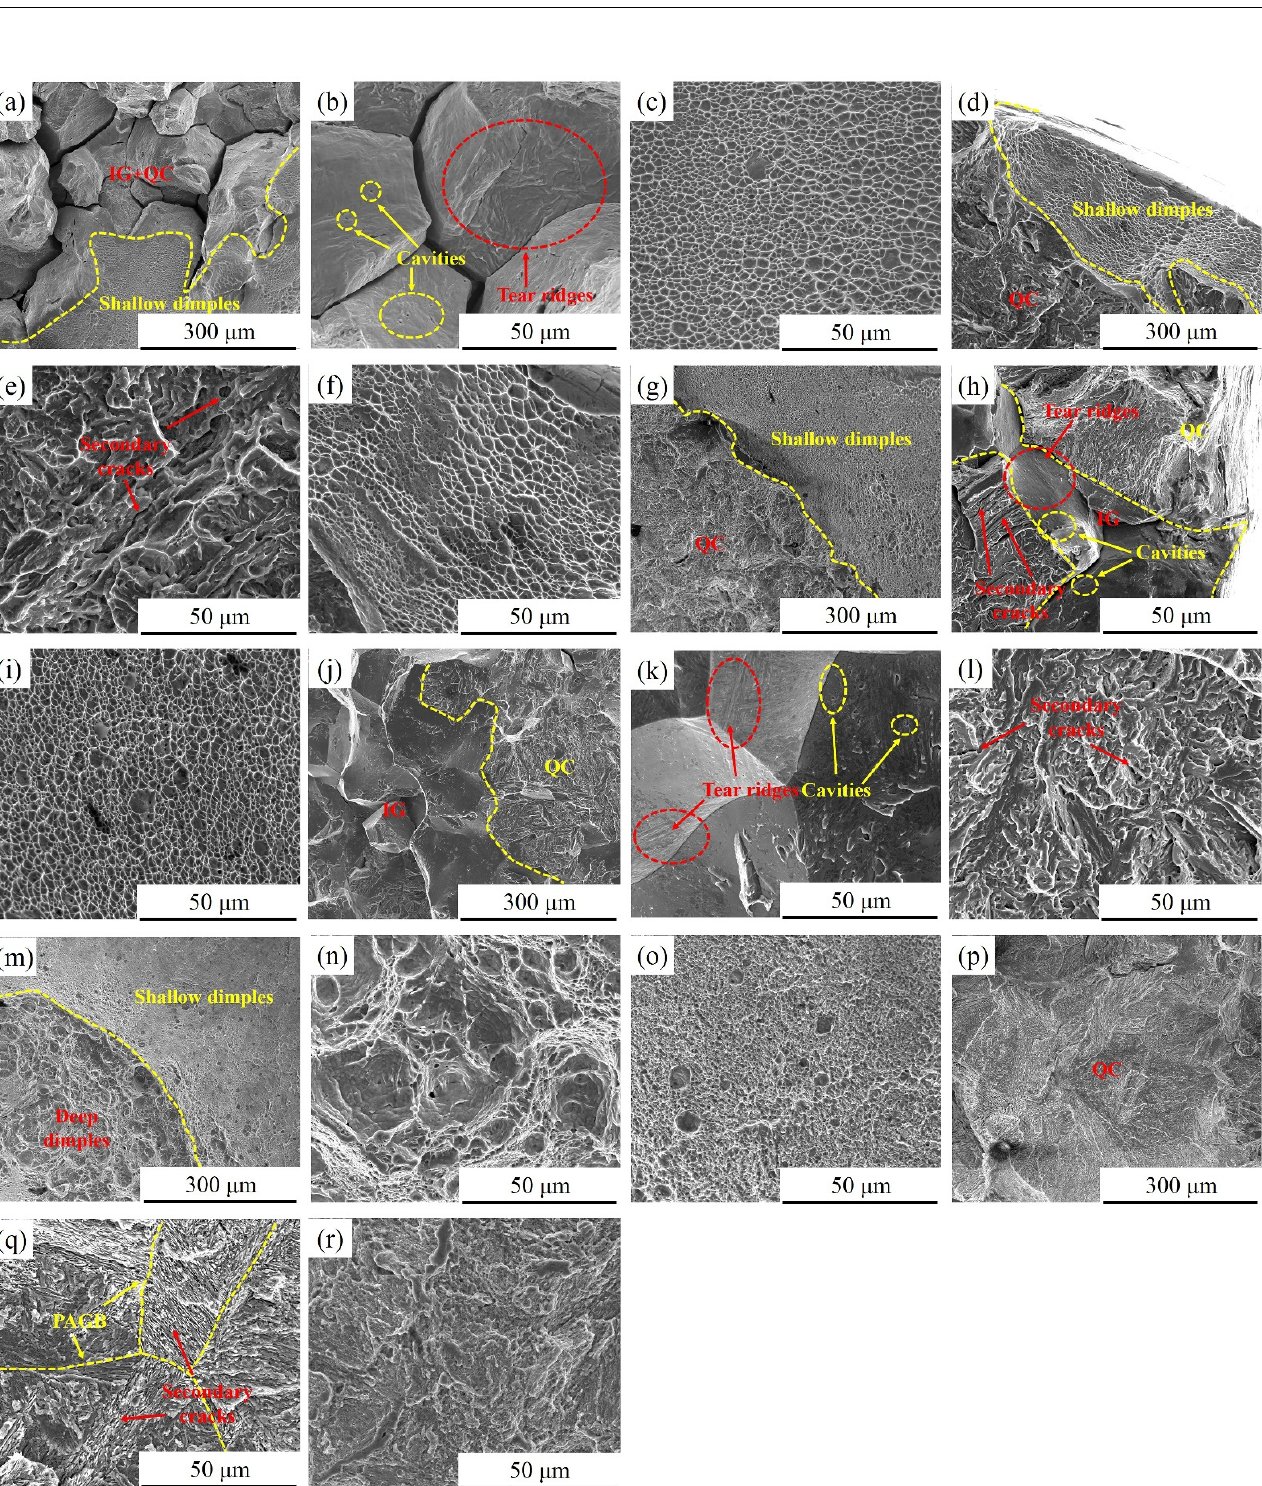
Figure 14. Morphology of the brittle fracture zone, plastic fracture zone and corresponding interface zone of the specimens in 3.5 wt.% NaCl solution: ( a – c ) 480A-0.5, ( d – f ) 480A-80, ( g – i ) 540A-0.5, ( j – l ) 540A-80, ( m – o ) 600A-0.5, and ( p – r ) 600A-80.